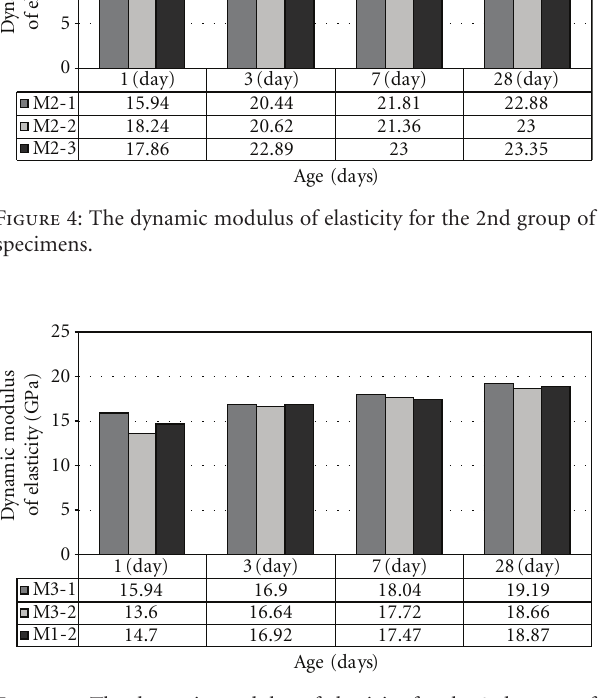
Figure 5: The dynamic modulus of elasticity for the 3rd group of specimens.